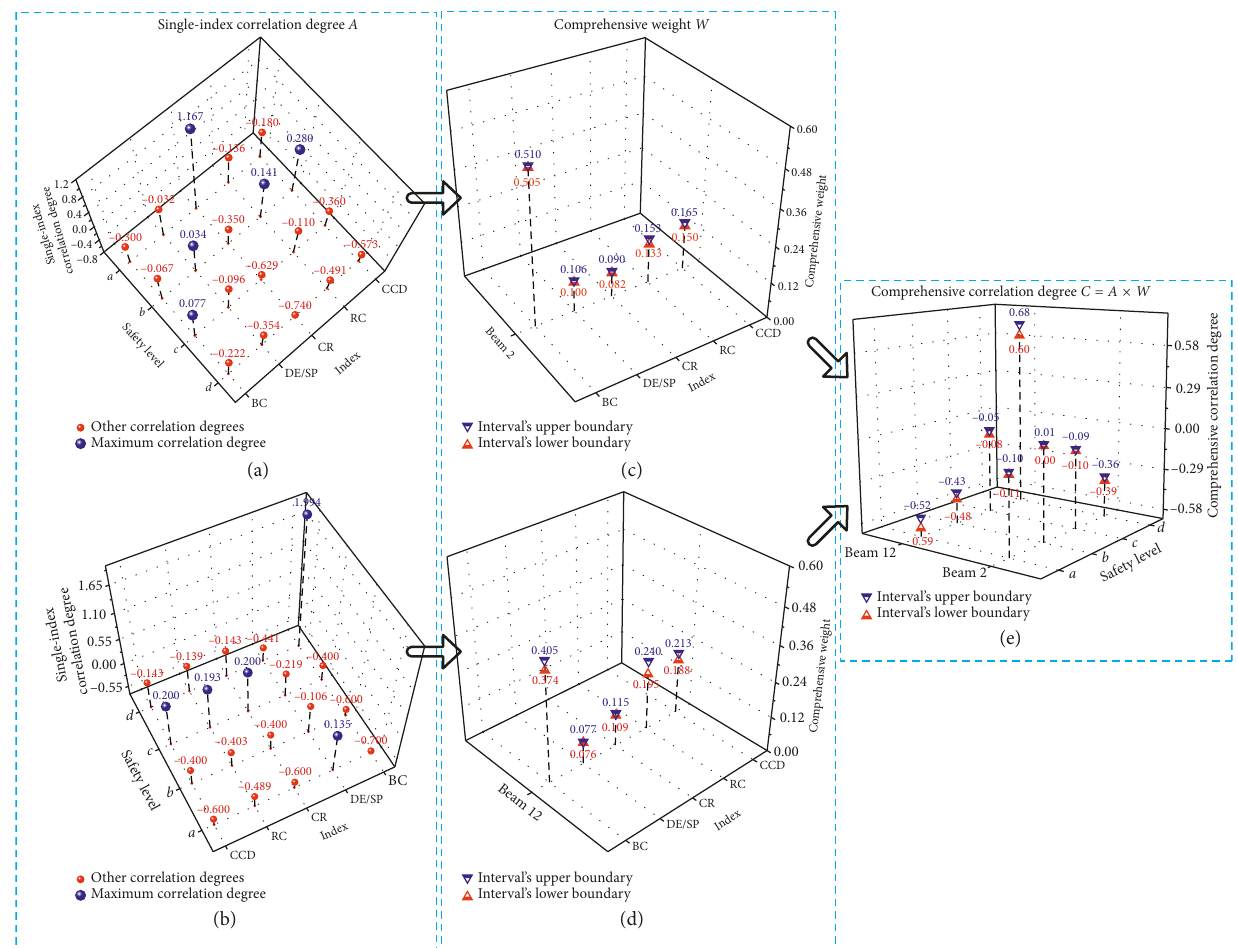
Figure 5: Extension model results. (a, b) The plane axes, respectively, represent safety level and index; the vertical axis represents the single index correlation degree; the blue dot represents the maximum correlation degree of each index and the red dots represent the other correlation degrees. (c, d) The inverse triangle (blue) and regular triangle (red), respectively, represent the upper and lower boundary of the comprehensive weight (which is an interval number). (e) The plane axes represent the safety level and the safety appraisal objects (beams 2 and 12); the vertical axis represents comprehensive correlation degree of each safety level; the inverse triangle (blue) and regular triangle (red), respectively, represent the upper and lower boundary of the comprehensive correlation degree (which is an interval number). Relationship: the comprehensive weight (i.e., (c) and (d)) integrates the single index correlation degree (i.e., (a) and (b)) into a com- prehensive correlation degree (i.e., (e)). BCsss, bearing capacity; DE/SP, deflection/Span; CR, cracks; RC, reinforcement corrosion; CCD, concrete carbonation